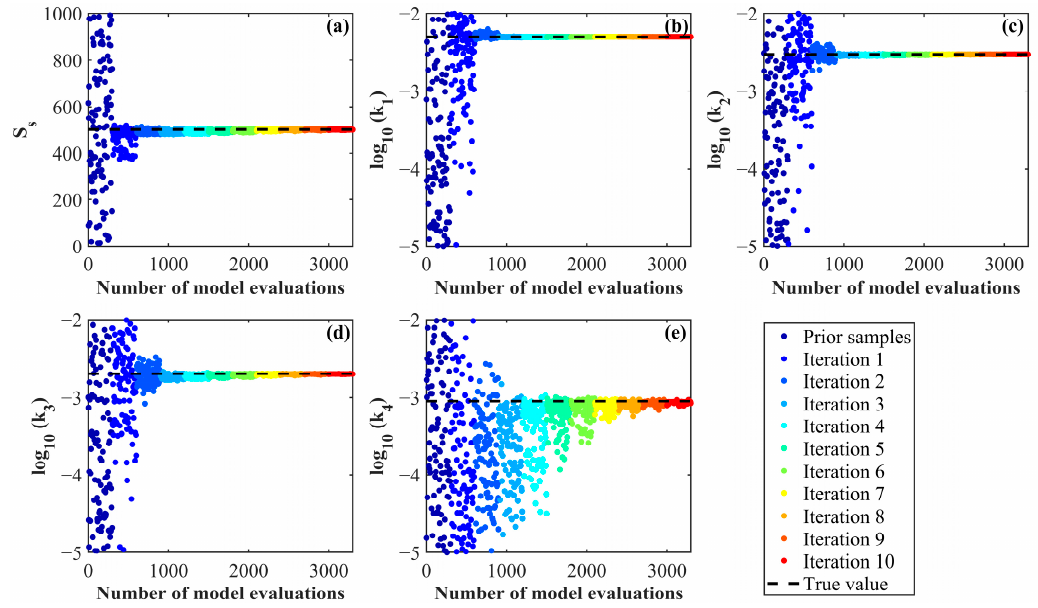
Figure 9. Trace plots of unknown model parameters estimated by the ILUES algorithm in Case 2. ( a ) represents the trace plot of the source strength ( S S ) . ( b – e ) represents the trace plot of the four rate constants ( k 1 , k 2 , k 3 , k 4 ) , respectively. The black dashed lines denote the reference true values of corresponding model parameters.